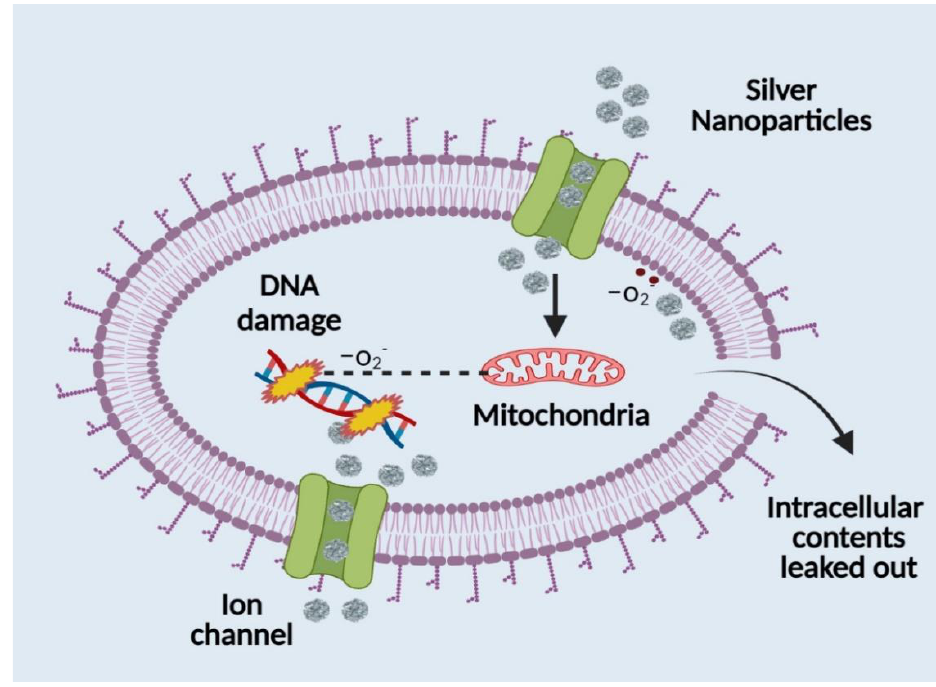
Figure 4. Antibacterial mechanism of silver nanoparticles.